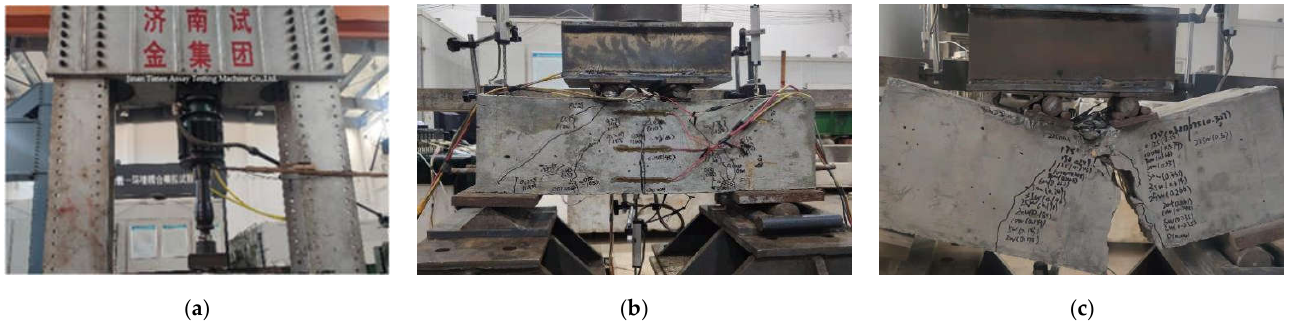
Figure 4. Test loading process: ( a ) test loading device; ( b ) specimen beams static loading test; ( c ) specimen beams fatigue loading test.